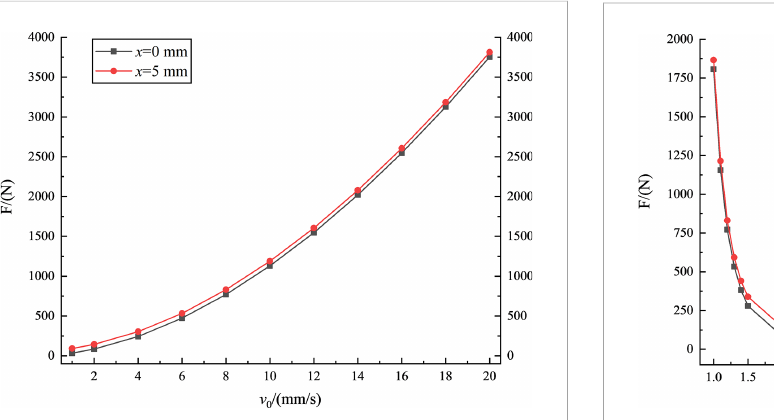
FIGURE 8 In fl uence of pressing velocity on pressing force.